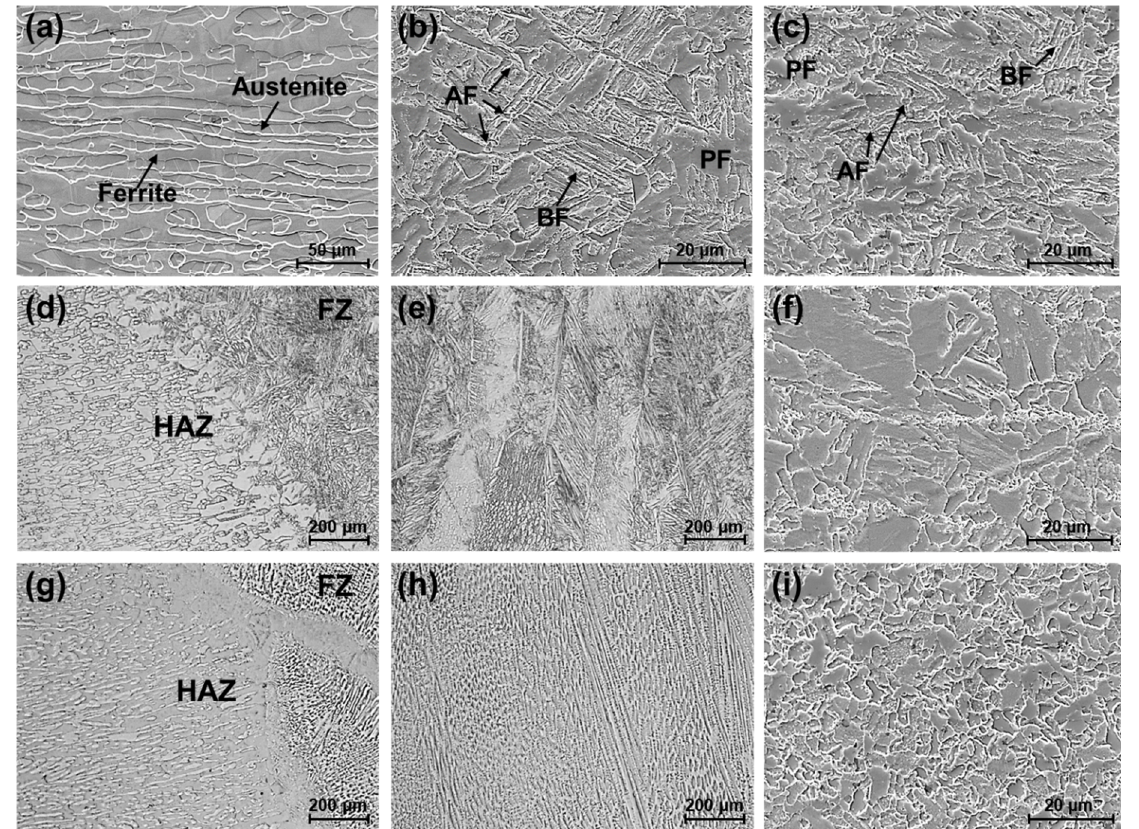
Figure 2. Micrographs of the ( a – c ) base metals, ( d – f ) DF joint using 2209 DSS filler metal, ( g – i ) AF joint using 309 LMo ASS filler metal: ( a ) duplex stainless steel (DSS), ( b ) CSD, ( c ) CSA, ( d , g ) heat affected zone (HAZ) of the DSS, ( e , h ) fusion zone (FZ), ( f , i ) HAZ of the carbon steels.